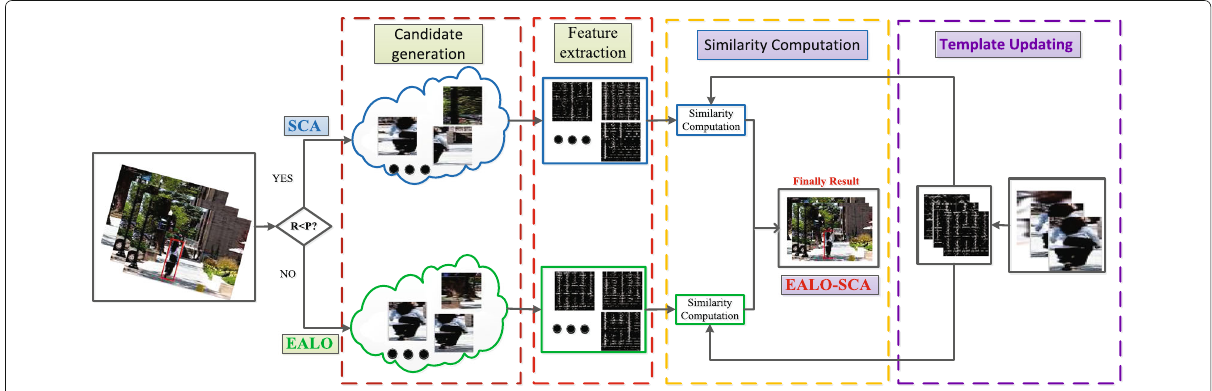
Fig. 5 The flowchart of the EALO-SCA